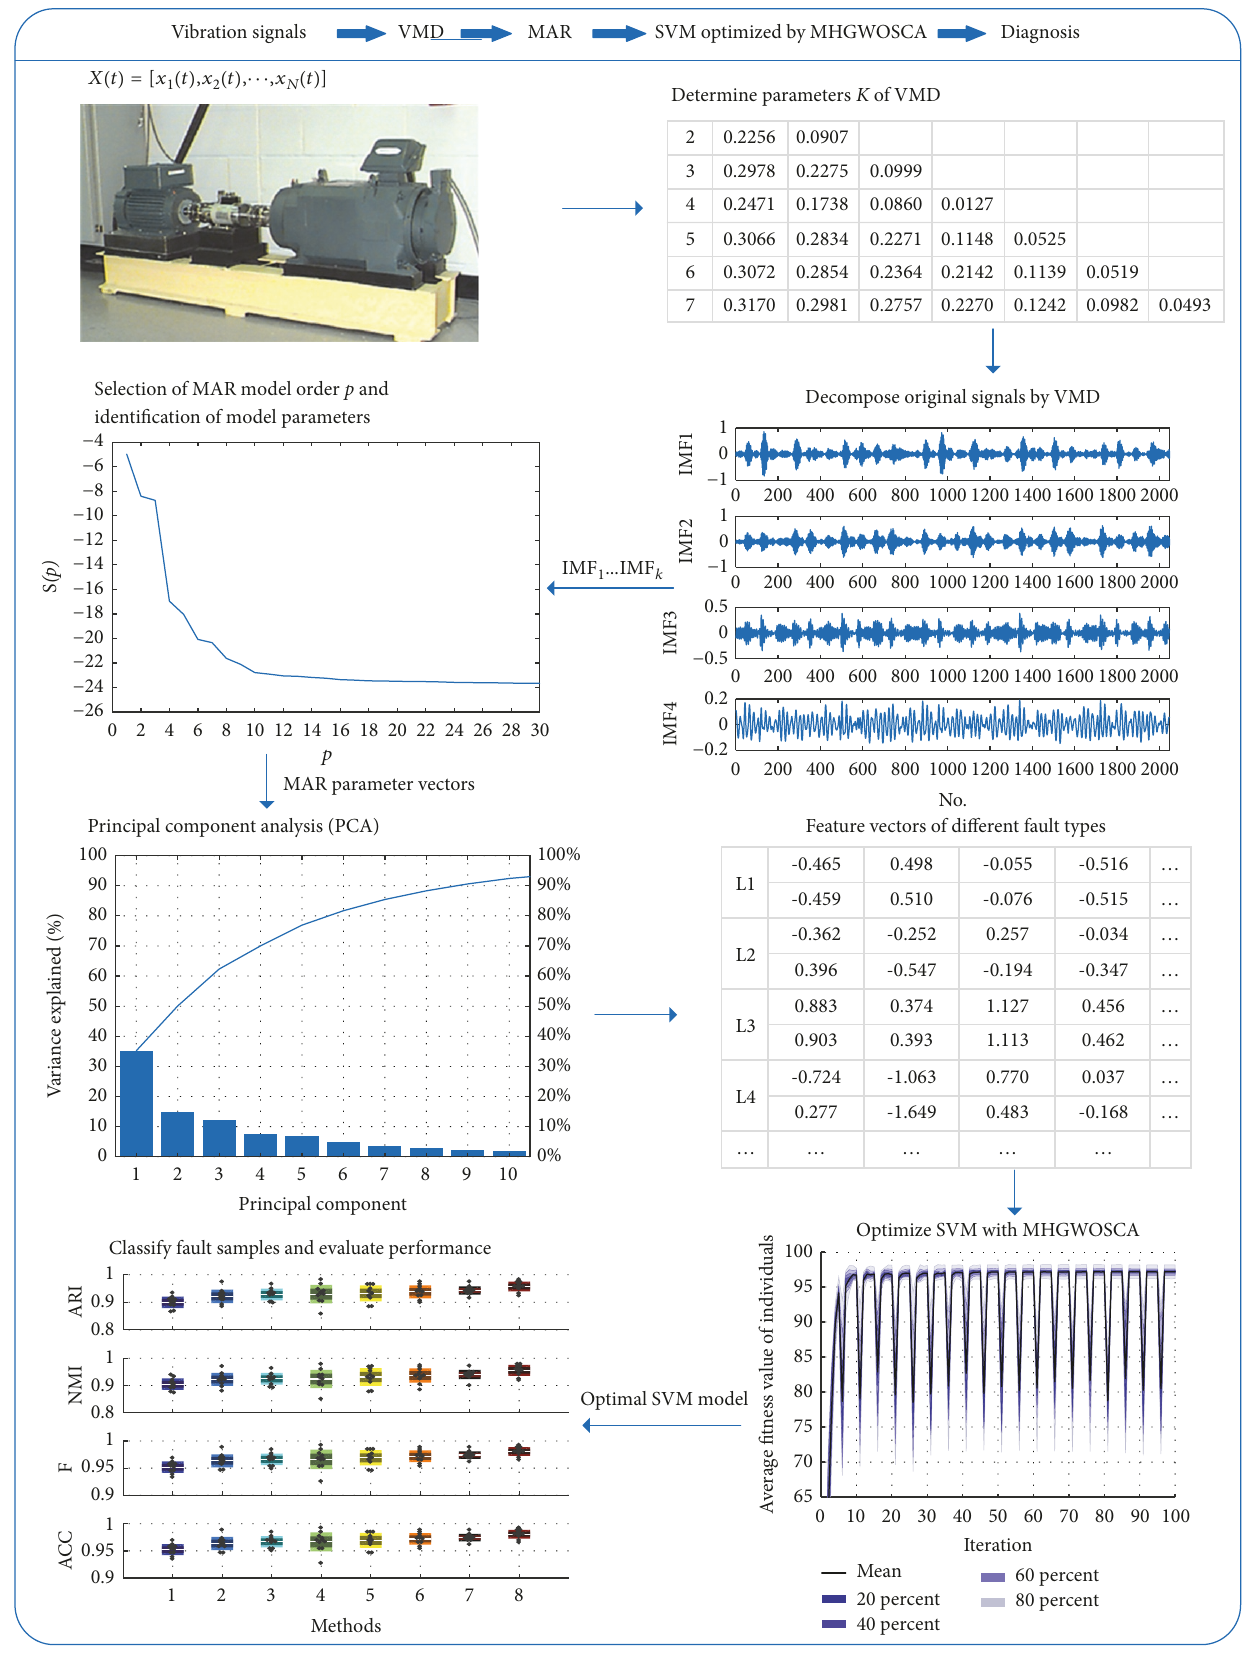
Figure 1: The flowchart of the proposed fault diagnosis